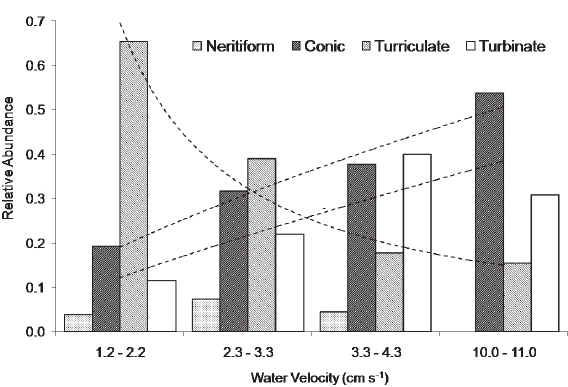
Fig . 4. – distribution of types of shells occupied by C. antillensis in montepio beach. dashed lines show the tendency of the relative abundance in the water velocity